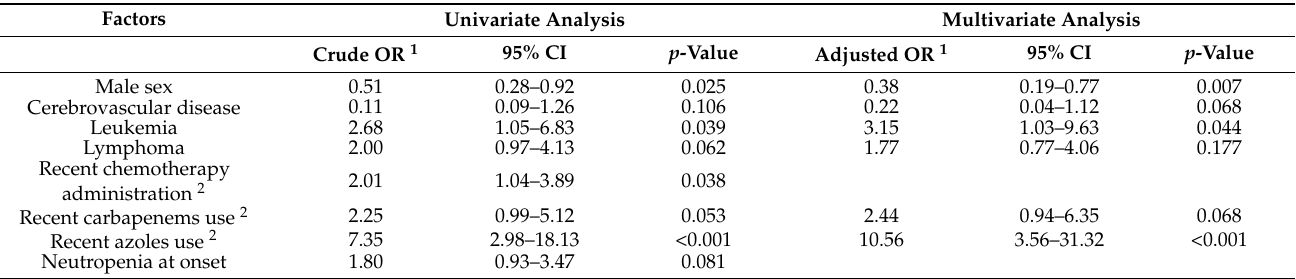
Table 2. Univariate and multivariate regression analyses of factors associated with fluconazole non-susceptible C. tropicalis blood isolates.